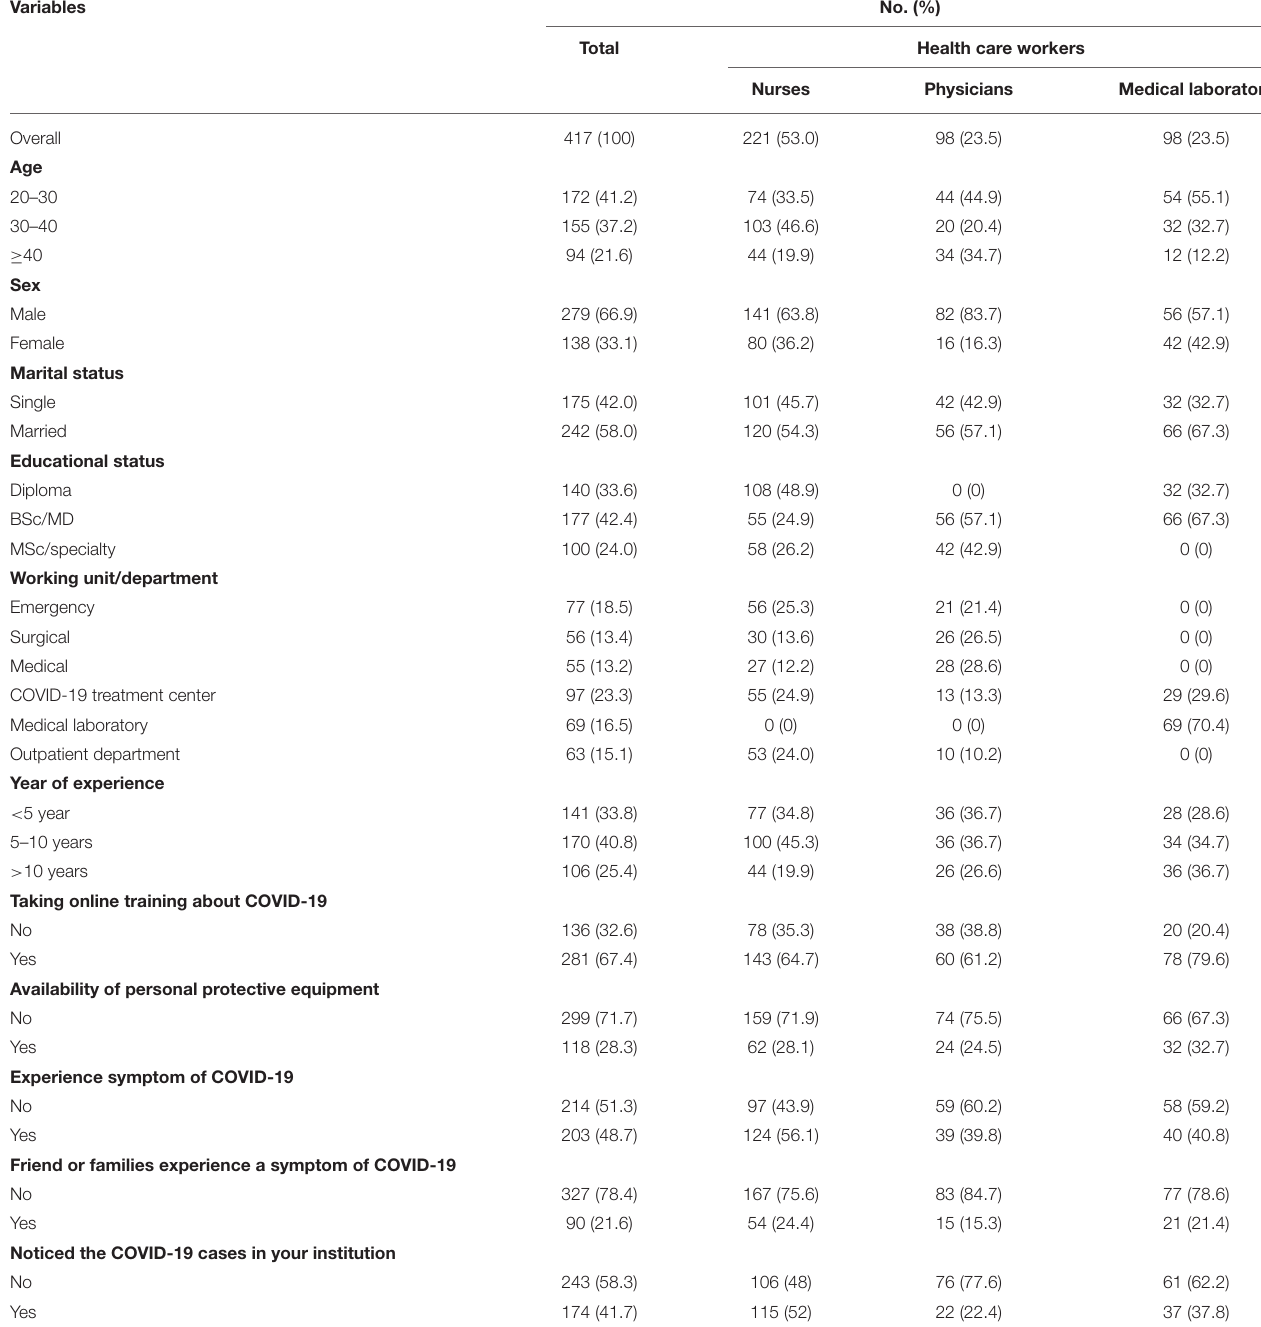
TABLE 1 | Socio-demographic and COVID-19-related characteristics of health-care workers in North Shoa Zone, Oromiya region July 2020 ( n = 417).